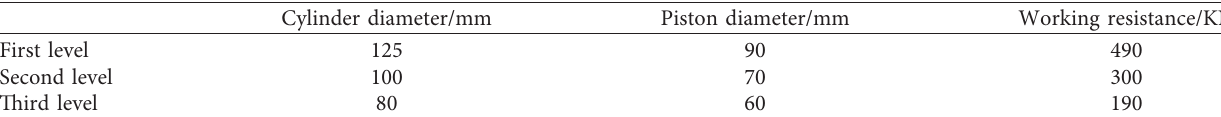
Figure 5: Dynamic analysis model of the face guard. (a) Integral face guard. (b) Split face guard. Table 1: Parameters of the face guard